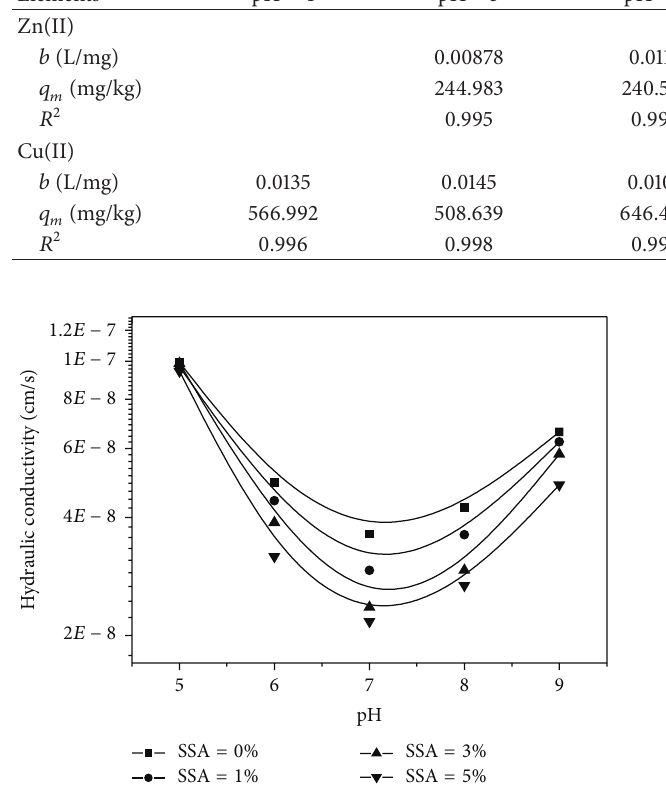
Figure 7: The hydraulic conductivity of the modified clay contain- ing SSA.